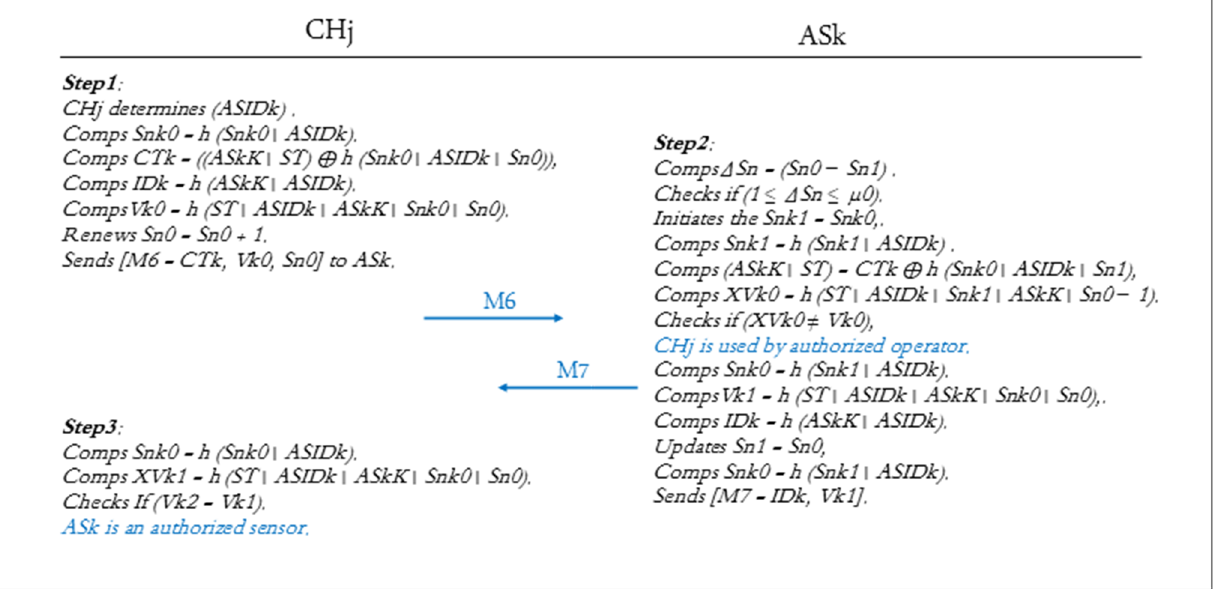
Figure 3. Authentication phase of agriculture sensor.